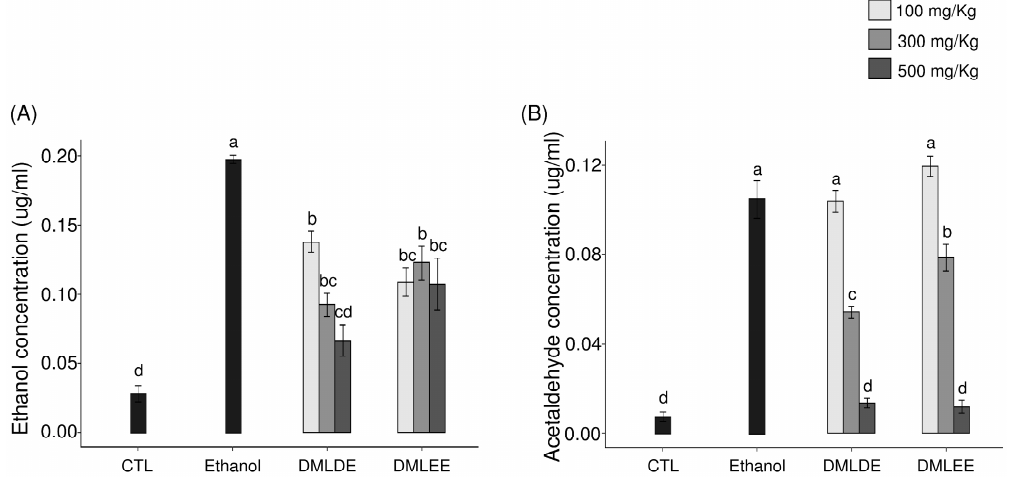
Figure 3. E ff ect of the Dendropanax morbifer leaf ethanol and D.W extracts on serum concentration of ethanol and acetaldehyde. ( A ) Ethanol concentration and ( B ) acetaldehyde concentration. The data are expressed as the mean ± SD ( n = 6), and di ff erent letters indicate (a > b > c > d) a significant di ff erence at p < 0.05, as determined by a Duncan’s multiple range test.